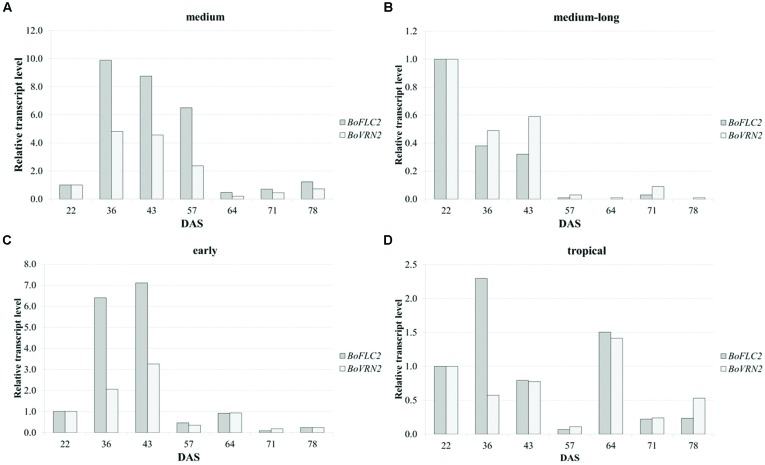
Time-dependent relative changes in transcript levels of BoFLC2 and BoVRN2 during curd induction in medium (A), medium-long (B), early (C) and cauliflower accession from the temperate zone and the tropics (D). Values represent mean relative changes in gene expression normalized to the control time point (22 DAS).